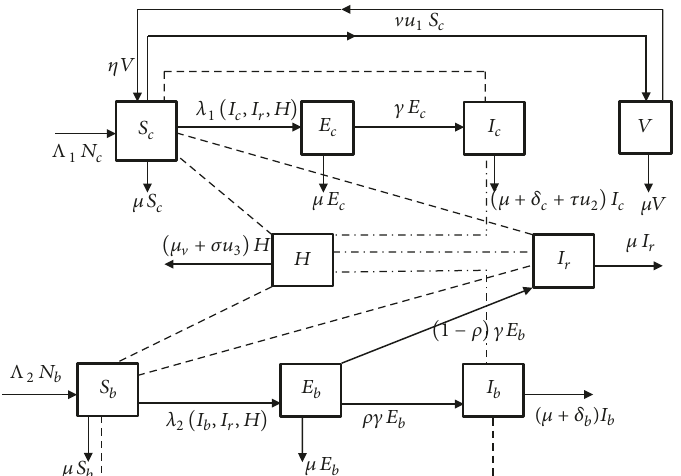
Figure 1: Flow diagram showing the dynamics of ND with vaccination, culling, and environmental hygiene and sanitation control measures.